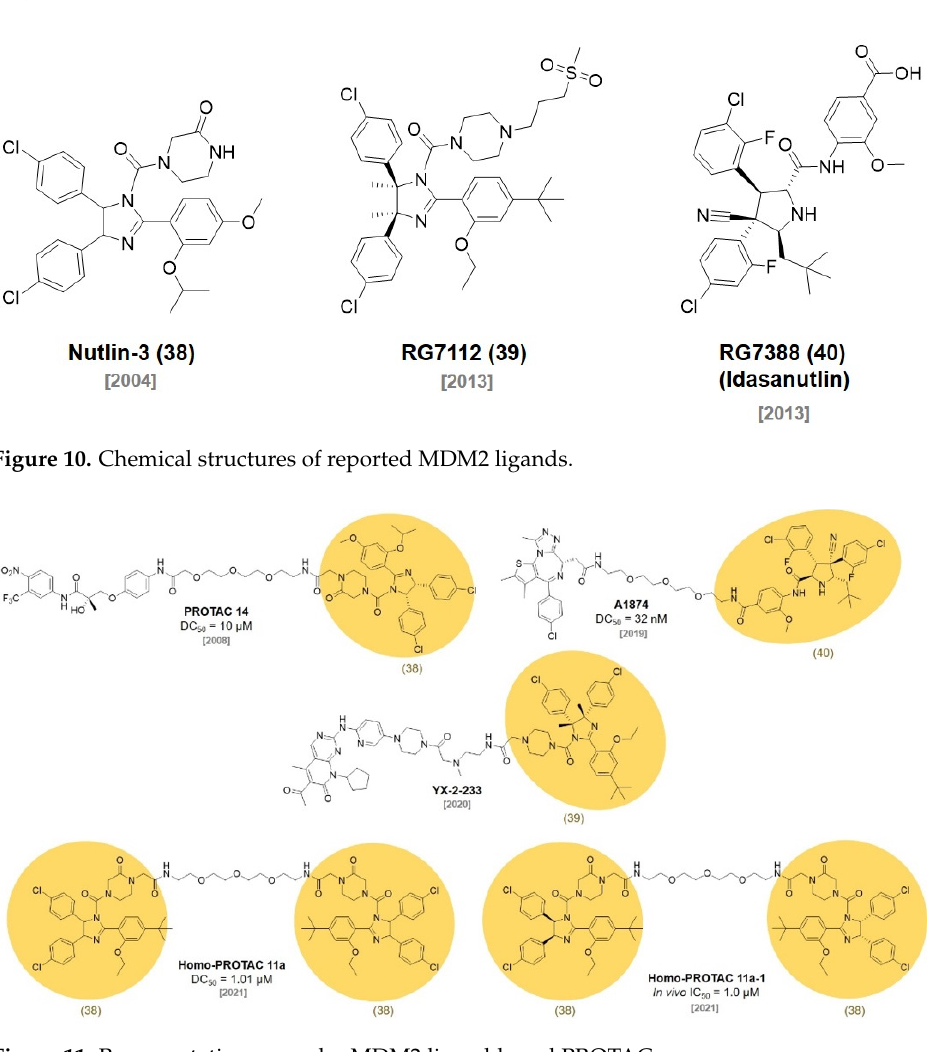
Figure 11. Representative examples MDM2 ligand-based PROTACs.